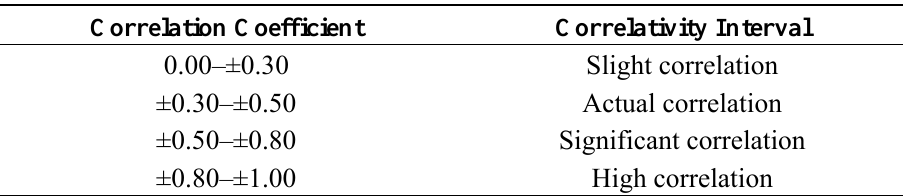
Table 2. The values of correlation